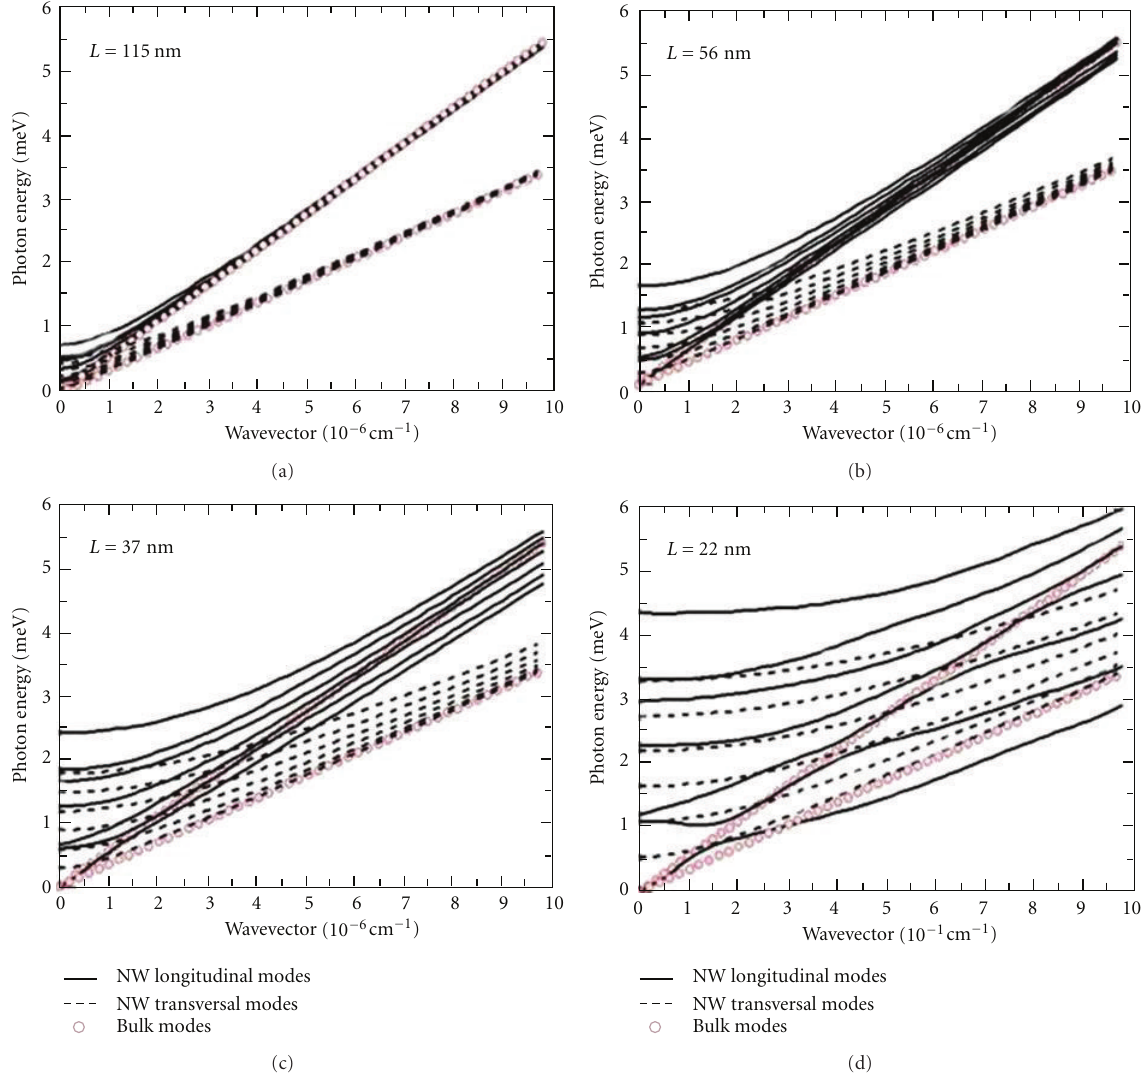
Figure 14: Elastic continuum approximation prediction of the dispersion relations for longitudinal (solid lines) and transversal (dashed lines) modes in Si nanowires of cross-sections 115, 56, 37, and 22 nm